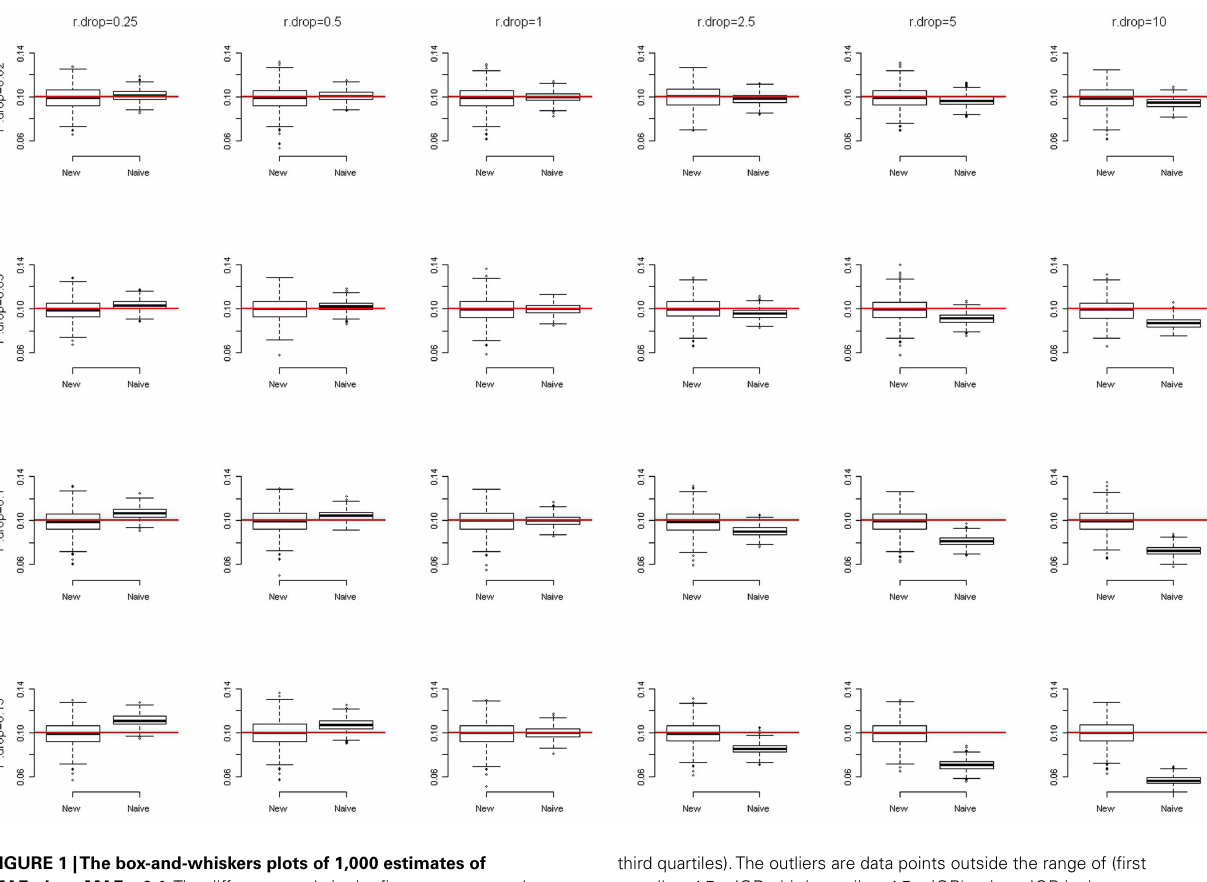
third quartiles).The outliers are data points outside the range of (first quartile − 1.5 × IQR, third quartile + 1.5 × IQR), where IQR is the inter-quartile range (third quartile − first quartile).The end of the upper whisker is the largest data point below the third quartile + 1.5 × IQR, while the end of the lower whisker is the smallest data point beyond the first quartile − 1.5 ×